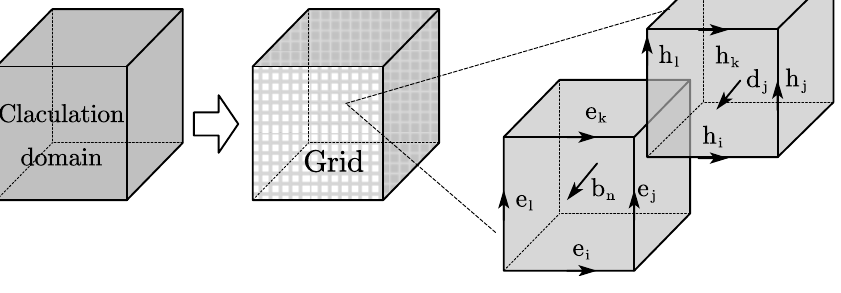
Figure 1. Maxwell’s grid division.